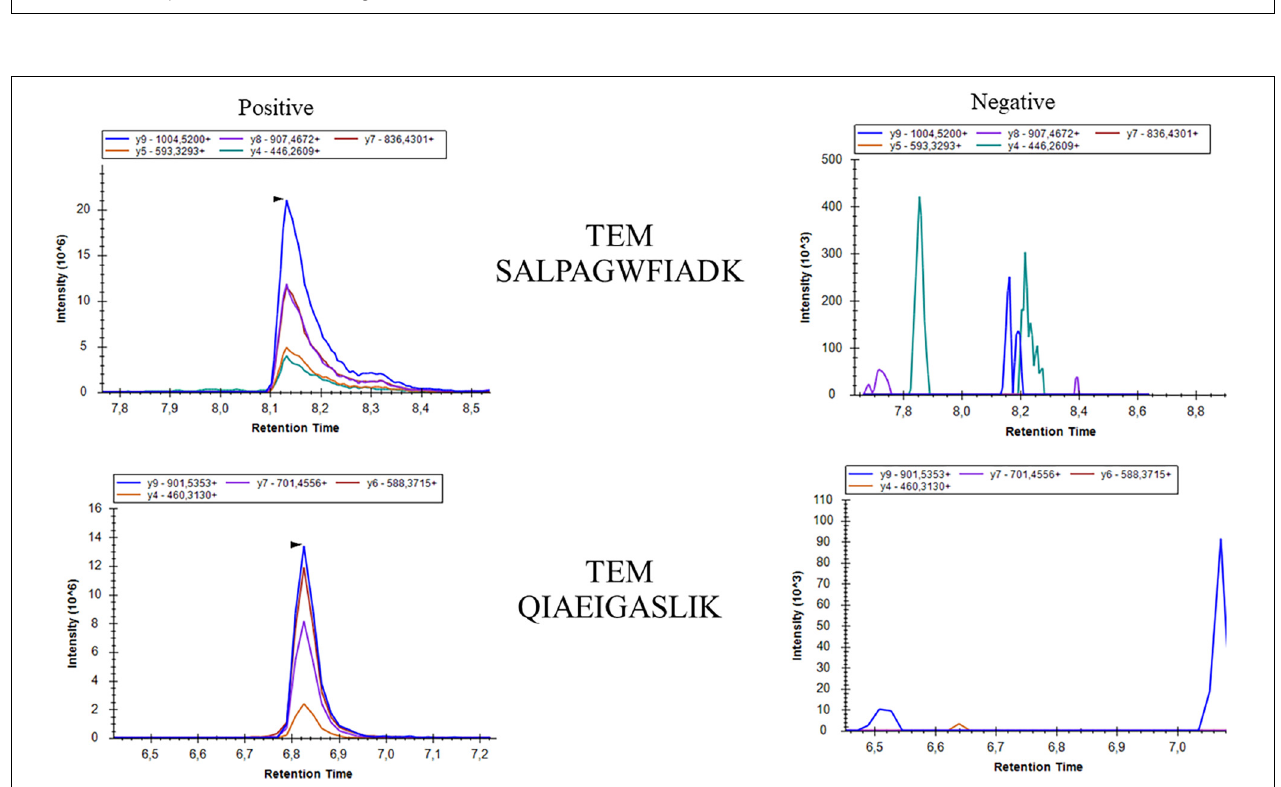
FIGURE 1 | Overview of the current protocol from positive blood culture to results. For each step, the approximate required time is indicated as well as the level of automation. PRM, parallel reaction